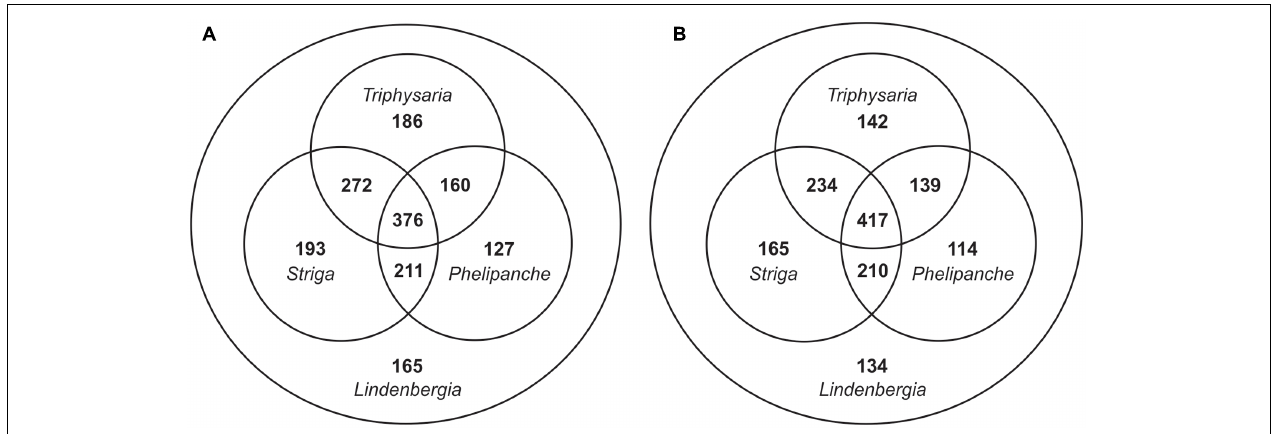
FIGURE 2 | Distribution of SCGs among the four Orobanchaceae focal species recovered using (A) gapped blast or (B) ungapped blast (see text for details).